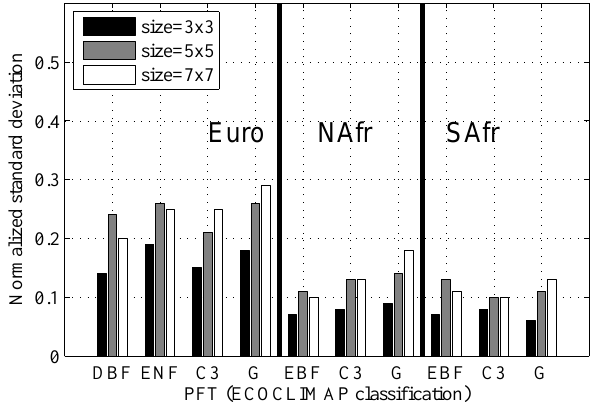
Fig. 8. Normalized PFT intra-variability (standard deviation) of LAI in function of the neighbourhood size for Europe (Euro) and Africa (NAfr and SAfr).